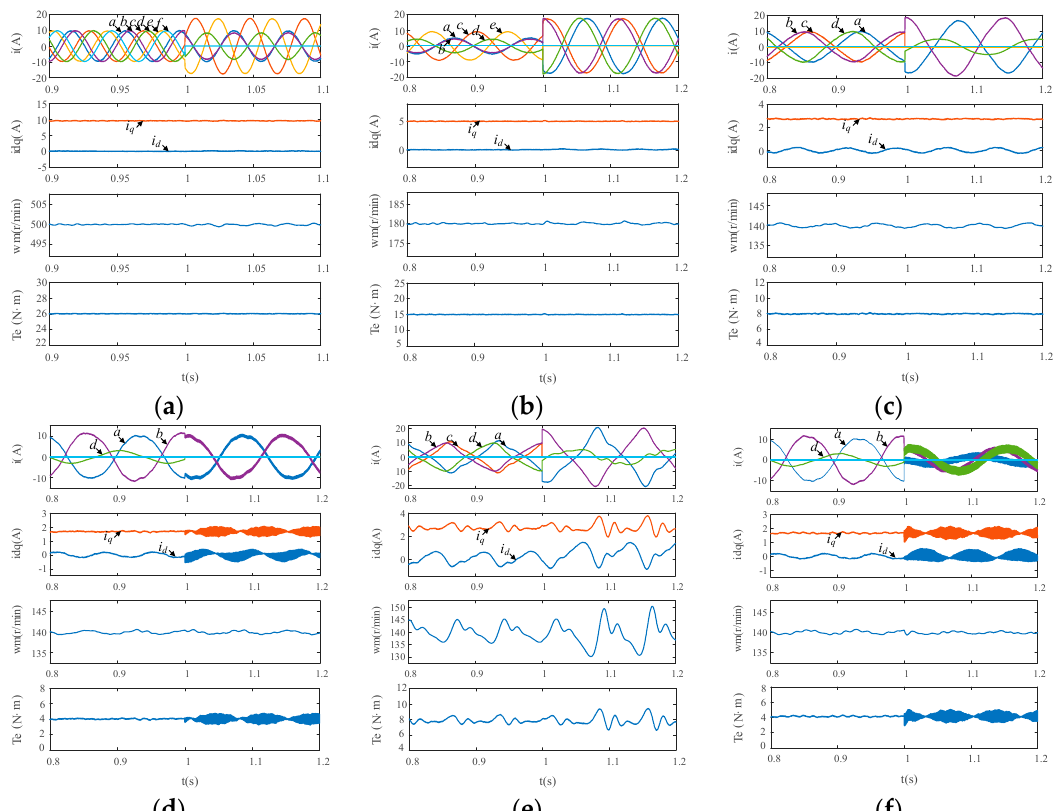
Figure 10. Simulation results. ( a ) From normal operation to Phase f open fault with dual current loops control. ( b ) From Phase f open to Phases e, f open fault with dual current loops control. ( c ) From Phases e, f open to Phases c, e, f open fault with dual current loops control. ( d ) From Phases c , e , f open fault without neutral point current to Phases c, d , e, f open fault with dual current loops control. ( e ) From Phases e, f open to Phases c , e , f open fault with traditional current control. ( f ) Phases c , e , f open fault from “no ‐ neutral ‐ current strategy” to “neutral ‐ current strategy” with dual current loops control.